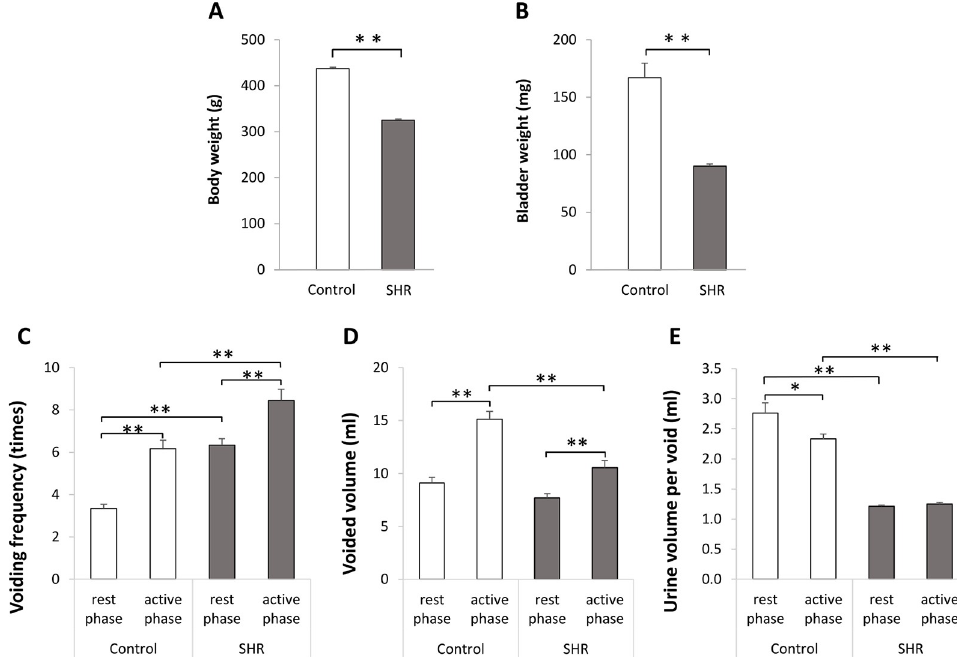
Fig 1. Body and bladder weight and results of voiding behaviors. A: Body weight in 18-week-old Wistar rats (control) and spontaneously hypertensive rats (SHR). B: Bladder weight in 18-week-old control and SHR. C: Voiding frequency in the rest and active phase in 18-week-old control and SHR under 12-h light/12-h dark cycle. D: Voided volume in the rest and active phase in 18-week-old control and SHR under 12-h light/12-h dark cycle. E: Urine volume per void in in the rest and active phase in 18-week-old control and SHR under 12-h light/12-h dark cycle. n = 36 in the control group; n = 36 in the SHR group. Student’s unpaired t -test was used for body and bladder weight data analysis. One-way analysis of variance (ANOVA) followed by Dunnett’s multiple comparison test was used for metabolic cage data analysis. � p < 0.05, �� p < 0.01.